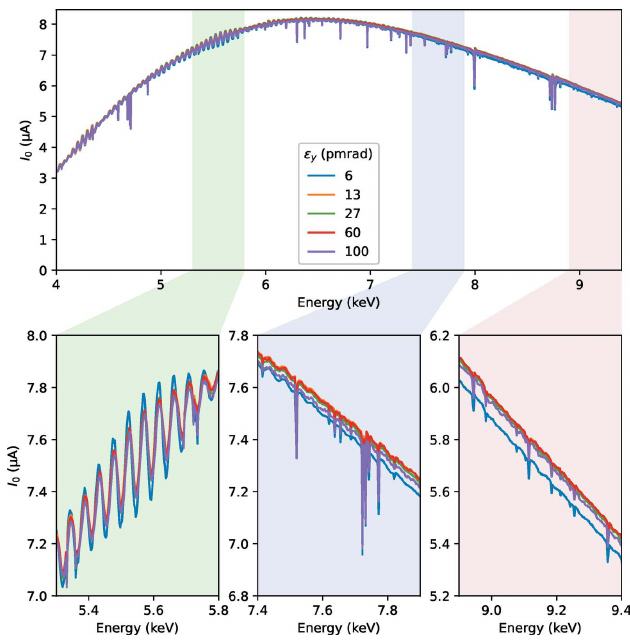
Figure 5 Experimental wiggler spectra at various vertical e-beam emittance " y , in the presence of field errors, with 0.25 mm taper and (cid:6) 100 m rad tilt.